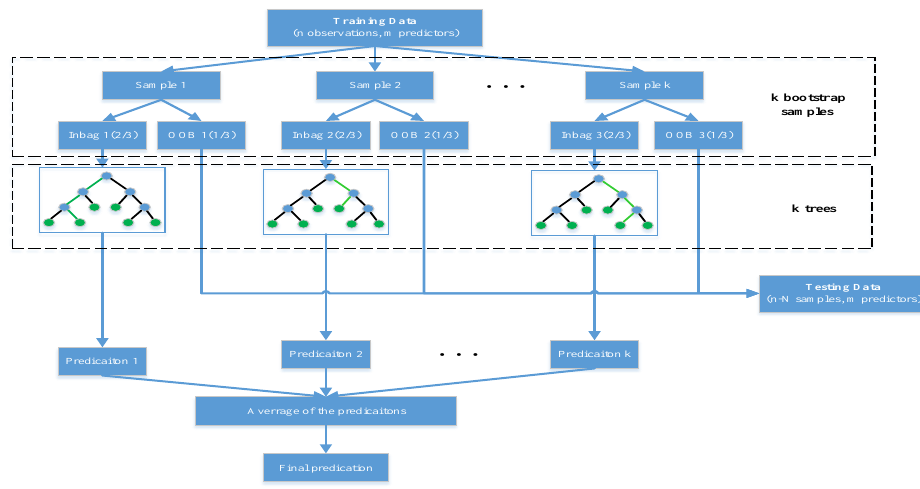
Figure 3. The flowchart of random forest for regression. OOB, out of bag.